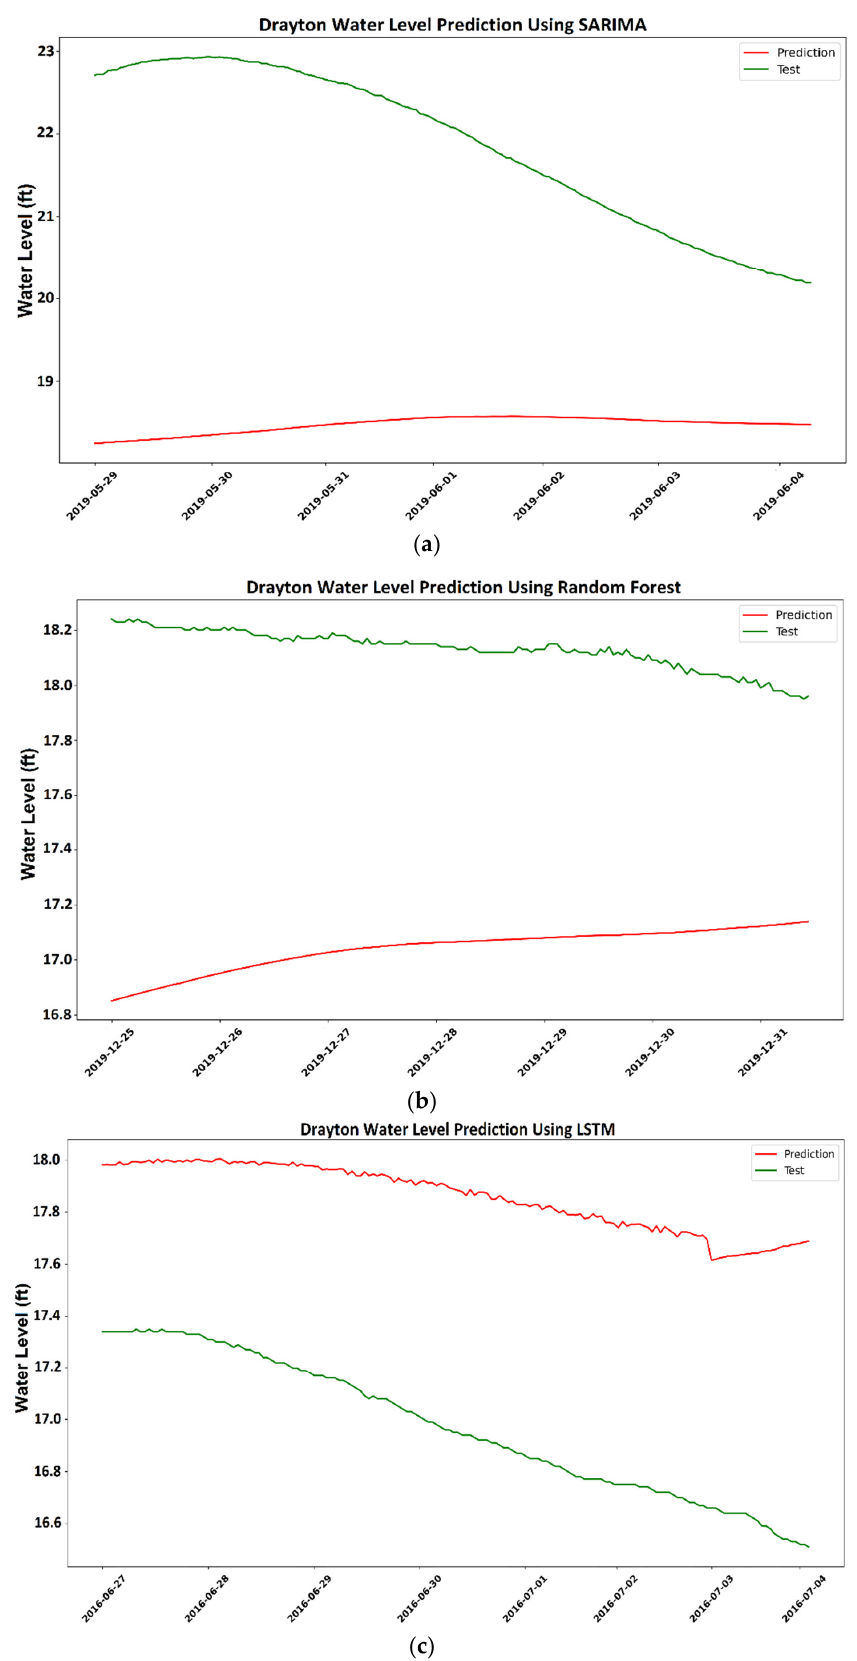
Figure 5. Visual comparison of one-week-ahead predicted values using ( a ) SARIMA, ( b ) RF, and ( c ) LSTM forecasting methods with true values on the Pembina series.